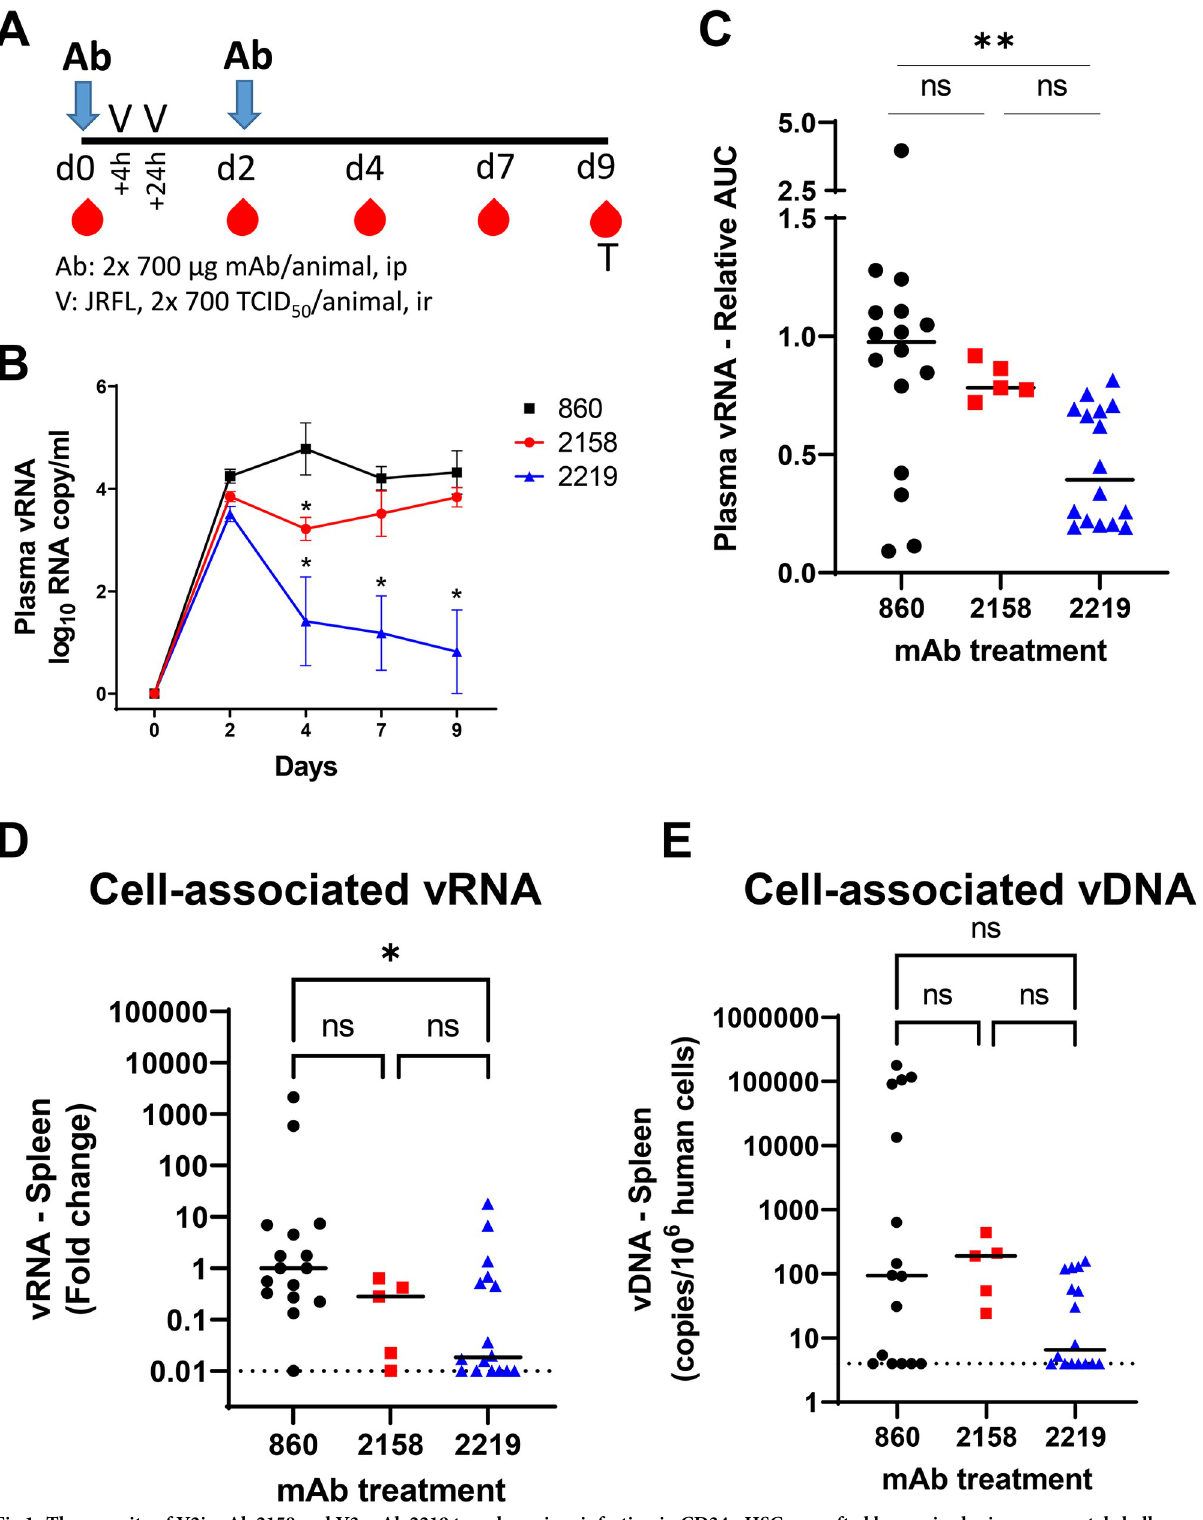
Fig 1. The capacity of V2i mAb 2158 and V3 mAb 2219 to reduce virus infection in CD34+ HSC-engrafted humanized mice upon rectal challenge with HIV-1 JRFL IMC. A) Schematic of experimental protocol showing that mice received intraperitoneal administration of mAb at day 0 and were challenged rectally with HIV at 4 hours and 24 hours. Animals received the second dose of mAb at day 2. Virus dose (2x700 TCID50 per animal) was